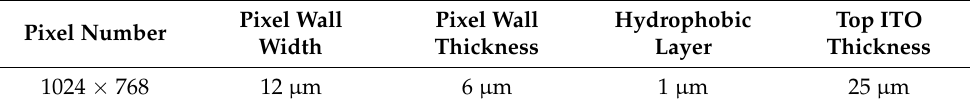
Table 2. Specifications of an 8 inch EWD panel.